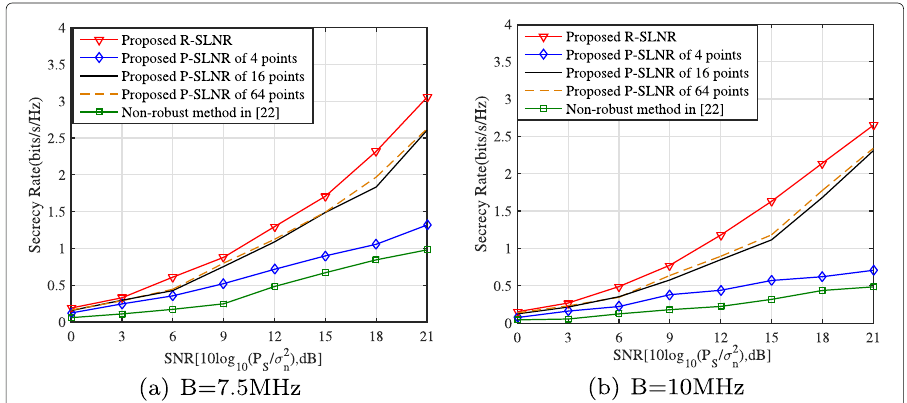
Fig. 7 The curves of secrecy rate versus SNR(10 log 10 ( P /σ 2 n ) ) of the proposed methods with B = 7.5 MHz and N = 10 MHz